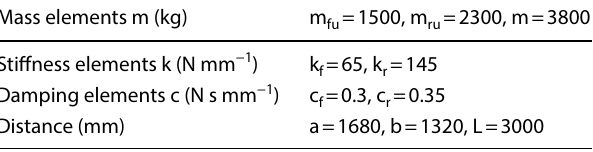
Table 1 The basic parameters of the